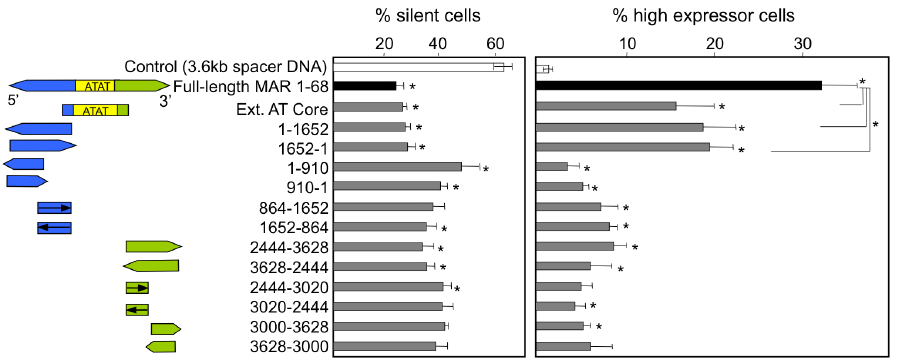
Figure 2. Identification of the portions of MAR 1–68 that contribute to the anti-silencing and transcriptional effects. The AT core extended region of the MAR 1–68, as well as a series of sub-fragments of the 5 9 and 3 9 flanking regions, were cloned upstream of the EGFP reporter gene in both orientation and analyzed for their effects on GFP expression levels. Constructs containing the full-length MAR 1–68 or a control spacer DNA cloned upstream of the EGFP reporter gene were also transfected as controls. GFP fluorescence was measured by flow-cytometry on polyclonal cell pools obtained after 2 weeks of antibiotic selection following transfection, and the proportion of silent and of high expressor cells were scored as illustrated in Fig. 1B. Results illustrate the mean and standard deviation of 3 independent experiments. Significant differences relative to the corresponding control construct containing spacer DNA of the same size, as illustrated in Suppl. Fig. S3, are indicated by stars above each bar, whereas line-associated stars indicate significant differences with constructs containing the full length MAR 1–68 or its extended core (Student test,